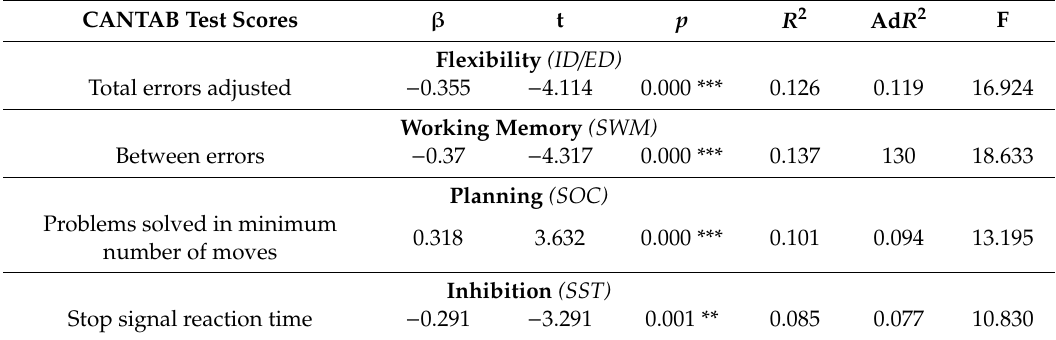
Table 8. Linear Regression Predicting the CANTAB Scores by Age for the Children with